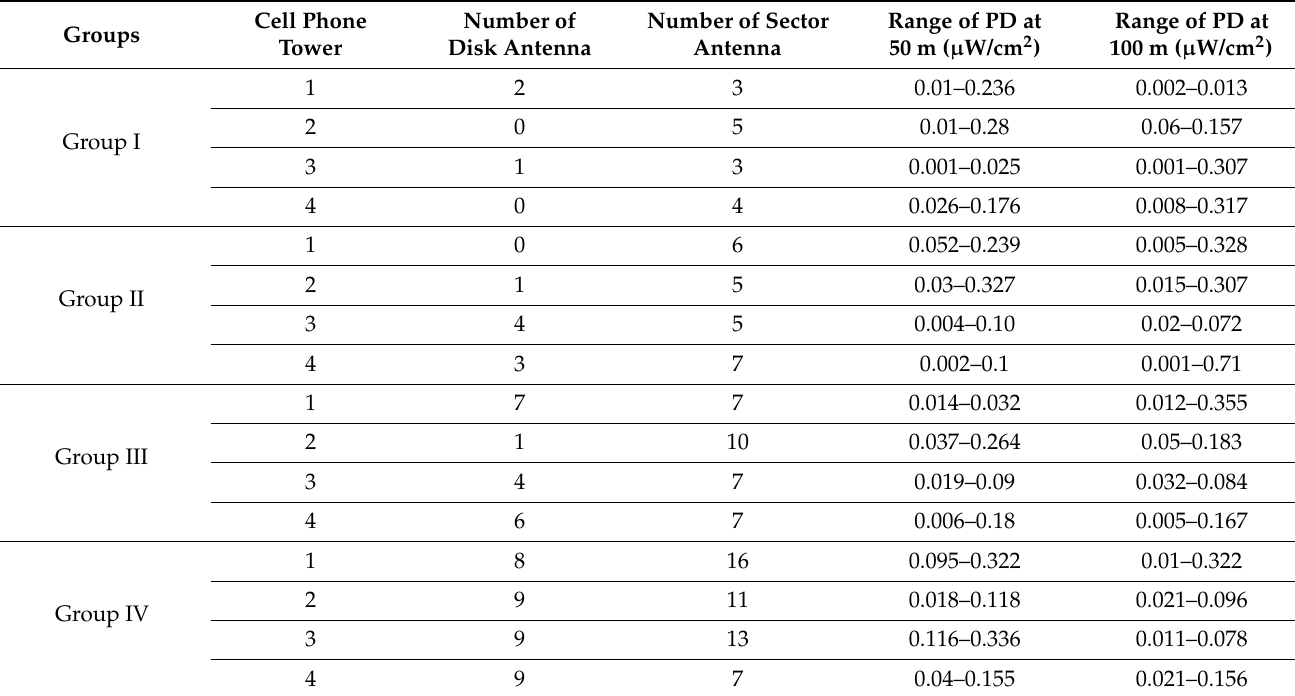
Table 1. Number of disk and sector antennas in a cell phone tower in all four groups and their PD